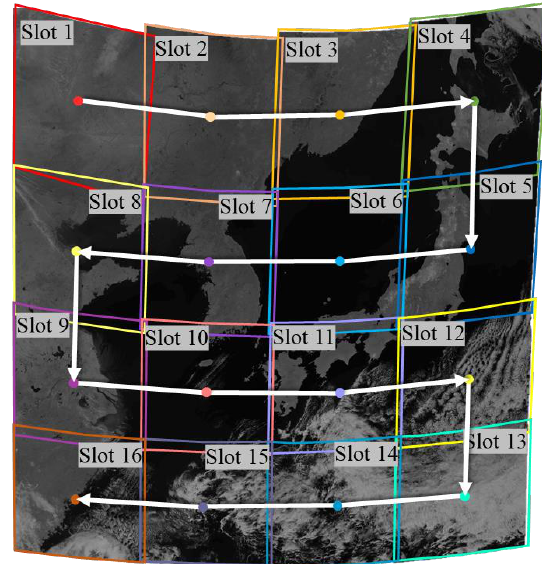
Figure 3. GOCI slot imaging sequence 2.1.3